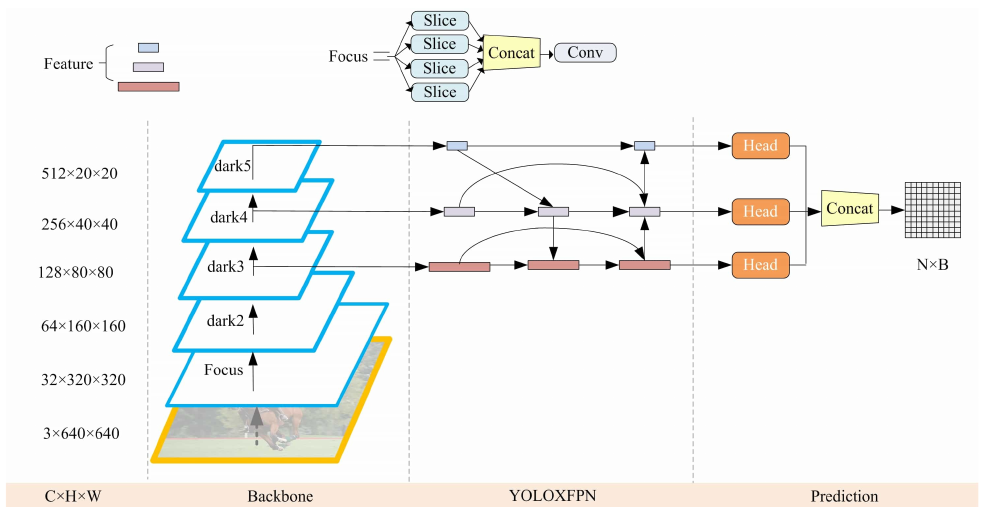
Figure 3. Overall framework diagram of our proposed intelligent weighted object detector, where C × H × W are the number of channels, height, and width of the feature map, respectively. Focus, dark2, dark3, dark4, and dark5 denote the convolutional layers in the backbone network, Focus takes a value for every pixel in an image; the details of the structure of dark2, dark3, dark4 and dark5 are given in the following sections. The rectangular squares in YOLOXFPN are all output feature maps. In the prediction part, the head is the prediction head of the model, the structure is the same as in the YOLOX model, and the prediction result N × B is output after combining the results of all the detection heads, where N is the information of the prediction frame and B is the number of prediction